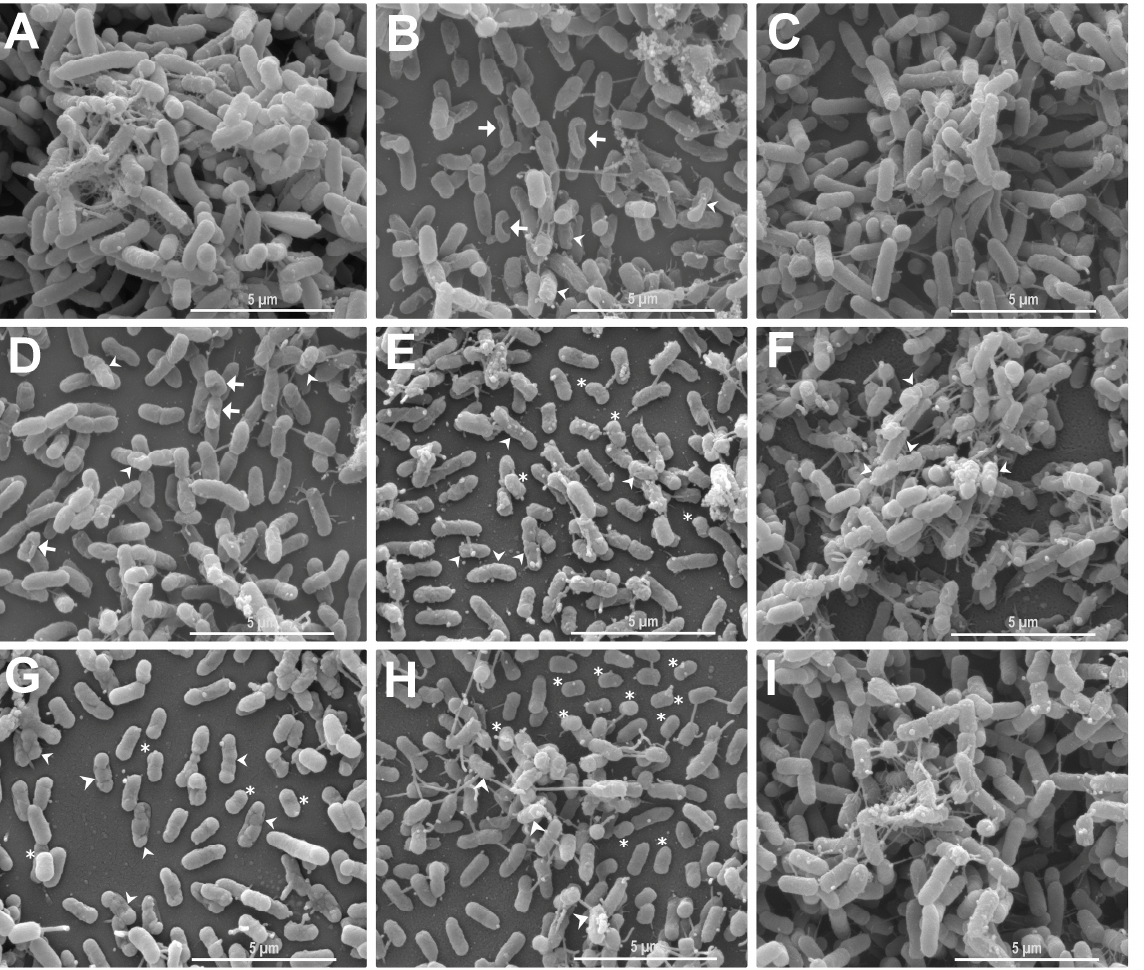
Figure 4. Scanning electron micrographs (magnification 20,000 × ) of the antibiofilm effect of oregano- derived antimicrobials and bioAgNP individually and in combination against enteroaggregative Escherichia coli (EAEC 042), showing biofilm cellular alterations in detail. Preformed biofilms (24 h) in glass slides were exposed for 24 h to eight different treatments at subinhibitory concentrations. ( A ) Untreated control (bio fi lm at a later stage, 48 h of growth). ( B ) OEO at 0.3 mg/mL. ( C ) Car at 0.31 mg/mL. ( D ) Thy at 0.12 mg/mL. ( E ) bioAgNP at 7.88 µg/mL. ( F ) Combination of OEO (0.01 mg/mL) plus bioAgNP (3.94 µg/mL). ( G ) Combination of Car (0.15 mg/mL) plus bioAgNP (3.94 µg/mL). ( H ) Combination of Thy (0.06 mg/mL) plus bioAgNP (3.94 µg/mL). ( I ) Combination of Car (0.15 mg/mL) plus Thy (0.06 mg/mL). Micrographs ( A – I ) show the cell density, size, and shape of EAEC 042 and morphological changes on the cell surface. Arrows: sinking of the bacterial cell wall. Arrowheads: wrinkled cell surface. Asterisk: cells with reduced size compared to untreated control. Figure 5 consists of scanning electron micrographs (1000×) of EAEC 042 and KPC- producing K. pneumoniae bio fi lms grown for 24 h in glass slides. EAEC (Figure 5A) exhibits